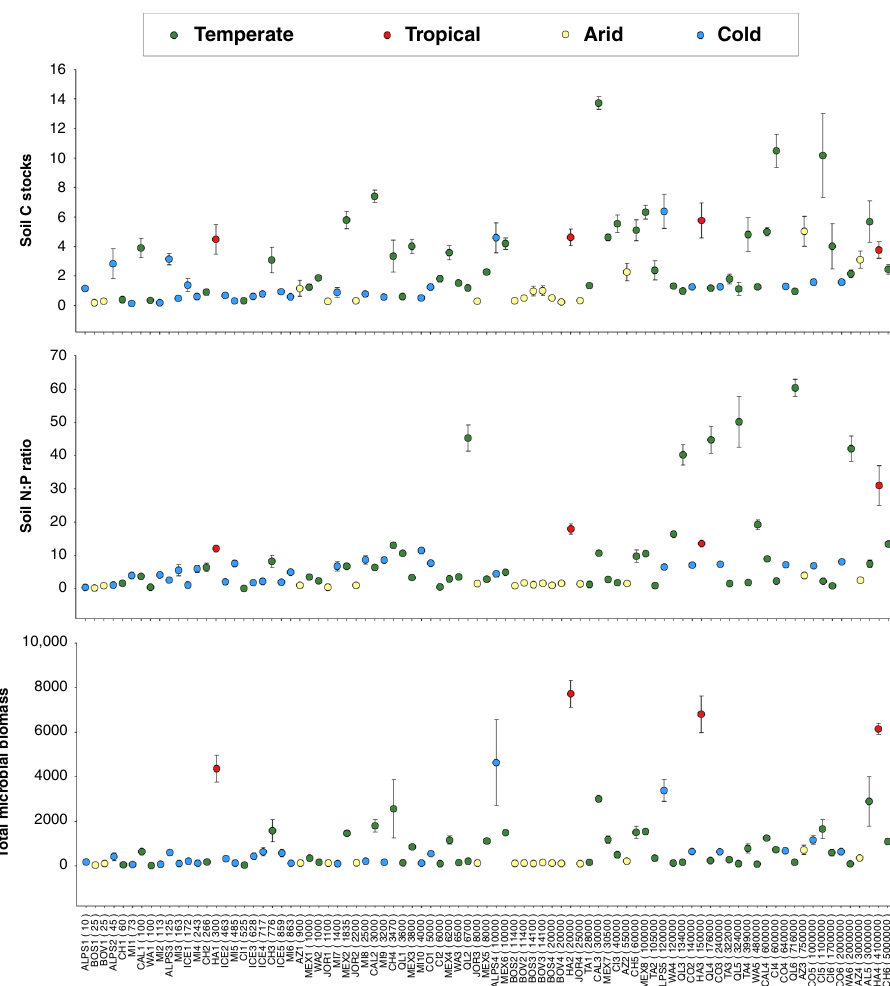
Fig. 9 Changes in selected ecosystem properties across climates and time. Changes in soil C stocks, N:P ratios, and total microbial biomass (mean ± SE) across soil ages and biomes ( n = 5 replicates per chronosequence stage). C stocks in kg C m − 2 ; microbial biomass in nmol PLFA g − 1 dry soil. Soil age (years) in brackets. Green circle = temperate; yellow circle = arid; blue circle = cold (continental and polar); red circle = paleoclimatic data (Worldclim database) from 64 soil chronosequences across the globe including the 16 chronosequences from this study (Fig. 1) and 48 other comparable soil chronosequences, using a global assessment of published data (Supplementary Fig. 1). Note that the current climate provided a good repre- sentation of the existing climate in multiple globally distributed soil chron- osequences during hundreds of thousands of years, suggesting that locations where these chronosequences were developed experienced relatively small changes in precipitation and temperature patterns (Supplementary Fig. 5).